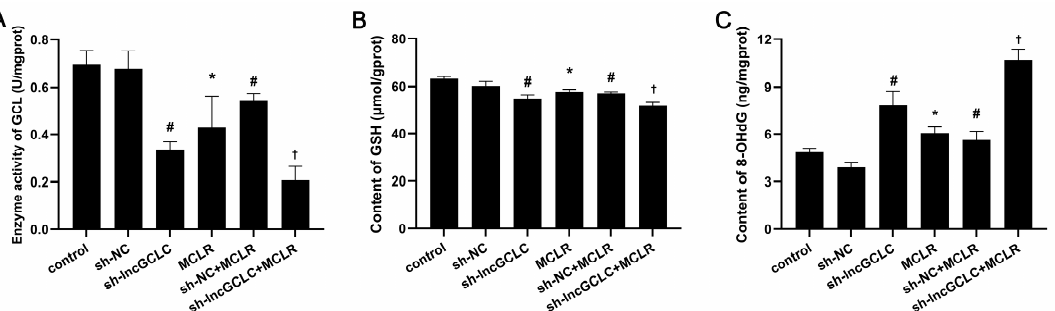
Figure 6. Knockdown of lncGCLC reduced GSH levels and induced oxidative DNA damage in MCLR-treated WRL68 cells. Alterations in GCL activity ( A ), GSH ( B ), and 8-OHdG content ( C ) in vector- or sh-lncGCLC-transfected cells exposed to 0 or 10 µ g/L of MCLR for 25 passages. Data are presented as the means ± SD of three independent experiments in each group. * p < 0.05 compared with the control group; # p < 0.05 compared with the sh-NC group; † p < 0.05 compared with the sh-NC + MCLR group.